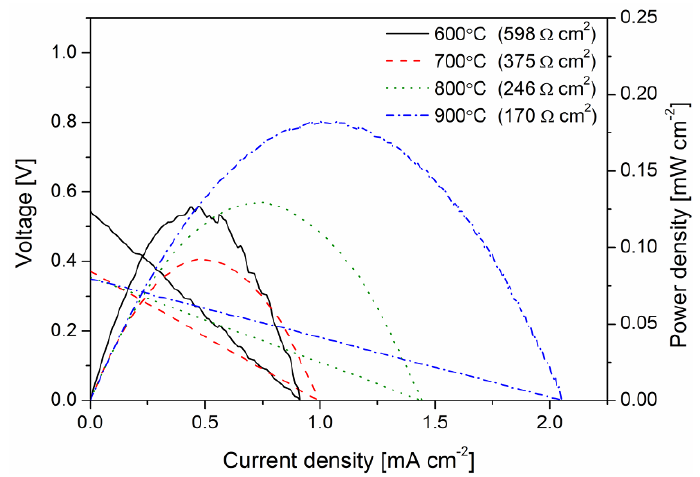
Figure 11. Voltage and power density as a function of current density of solid oxide fuel cell supported on BaCe membrane. Numbers in brackets denote total cell polarization.